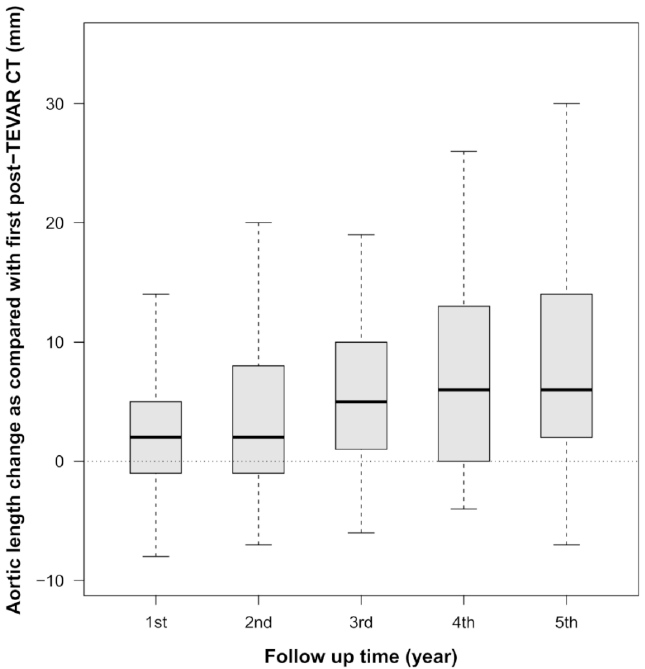
Figure 2. Aortic length change after Thoracic endovascular repair (TEVAR). The median change in